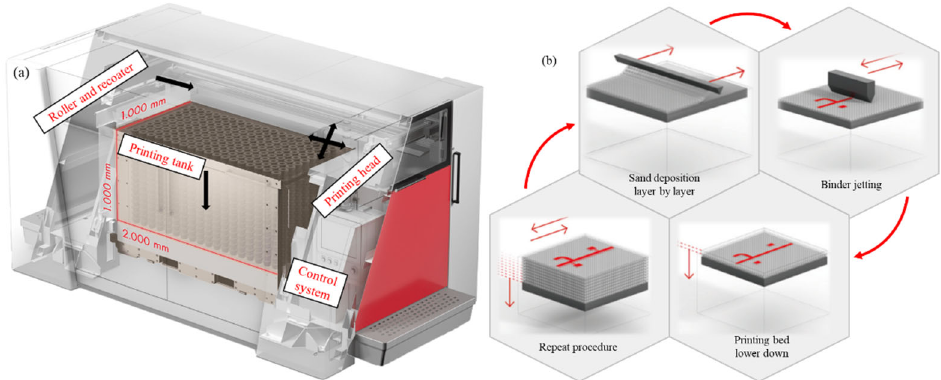
Figure 1. Schematic of the internal structure ( a ) and the main printing procedure ( b ) of the VX-2000 3D printer (the black arrows show the working orientation of different components).